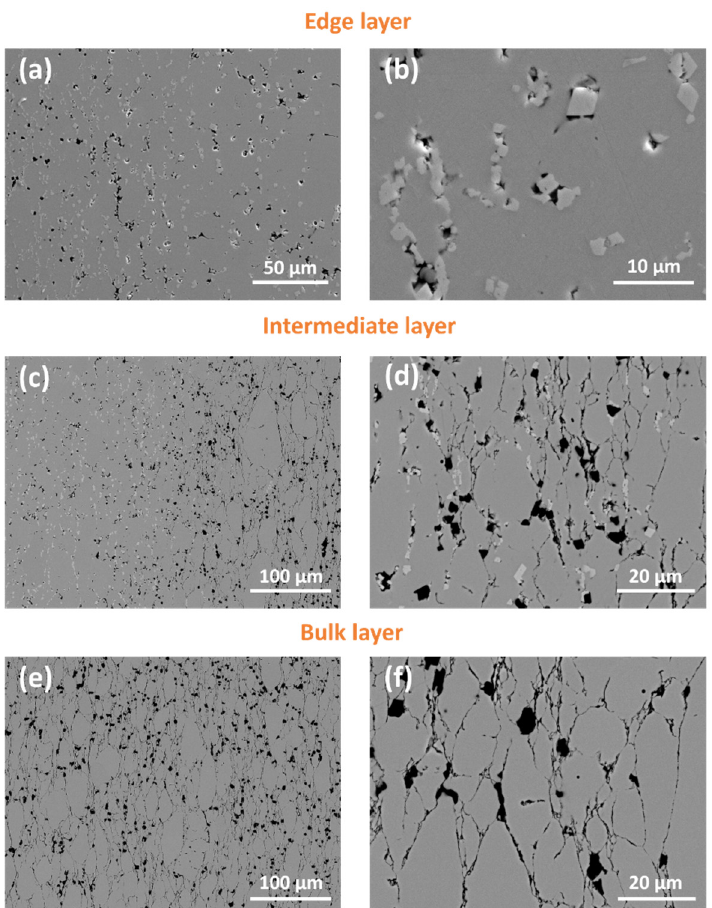
Figure 9. SEM images for 5 GAlN composite: ( a , b )—edge layer, ( c , d ) intermediate layer; ( e , f ) bulk layer.